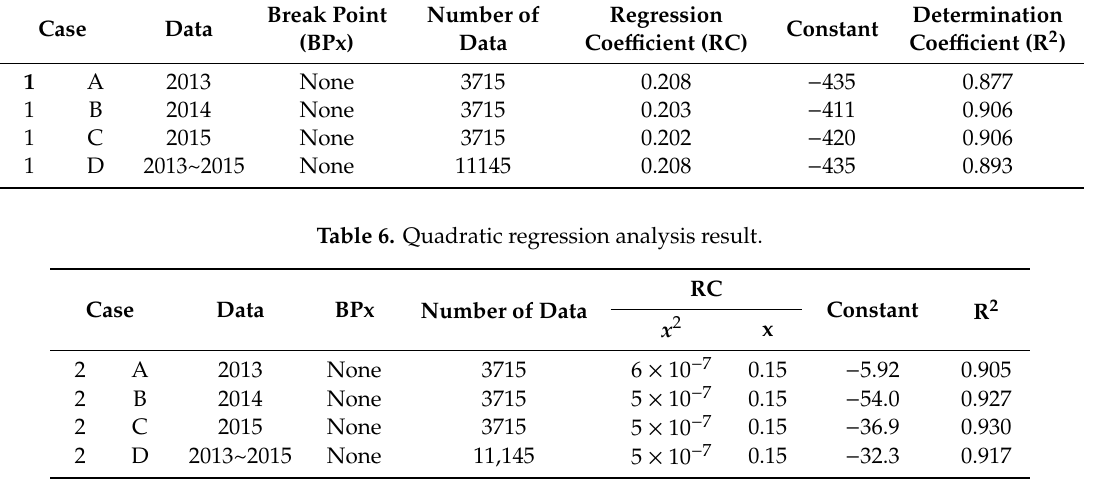
Table 7. Segmented regression analysis result.